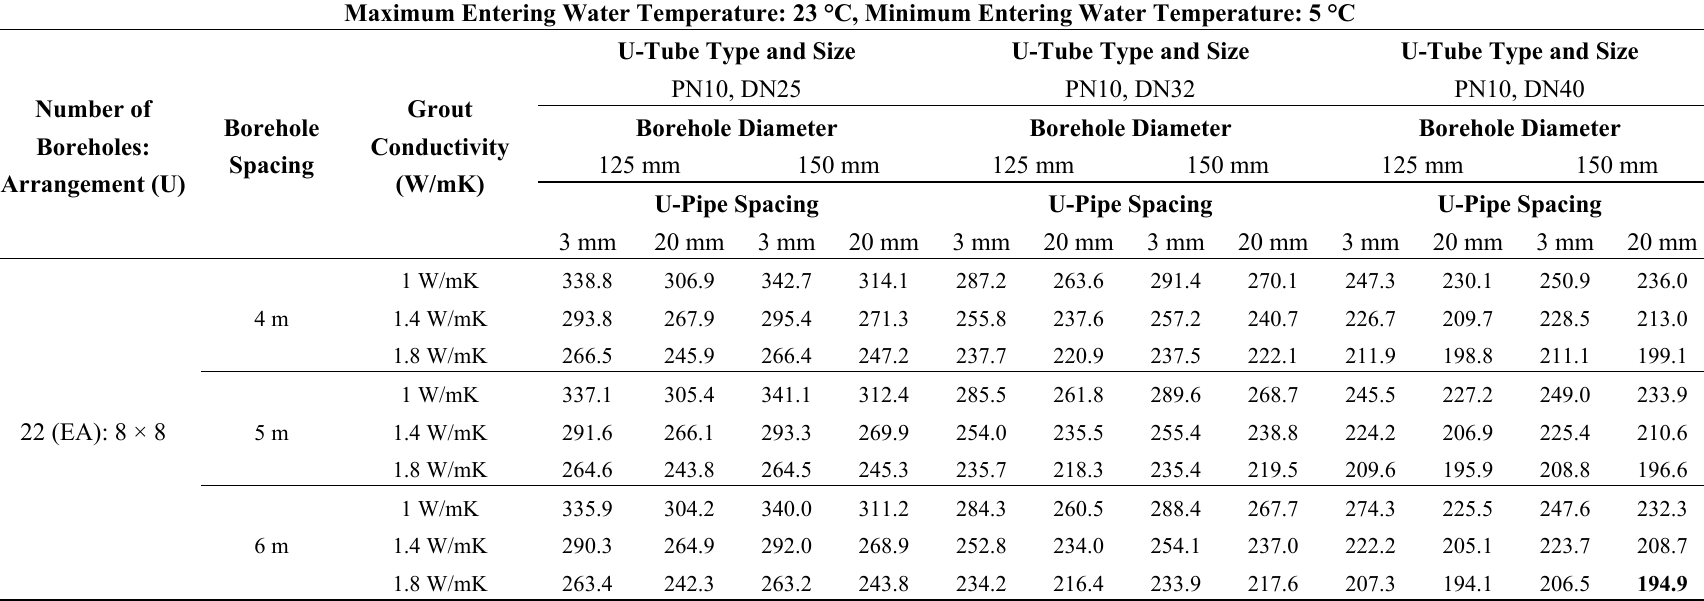
Table A4. Scenarios (length of borehole) of GHE considering EWT (20 °C) and characteristics of